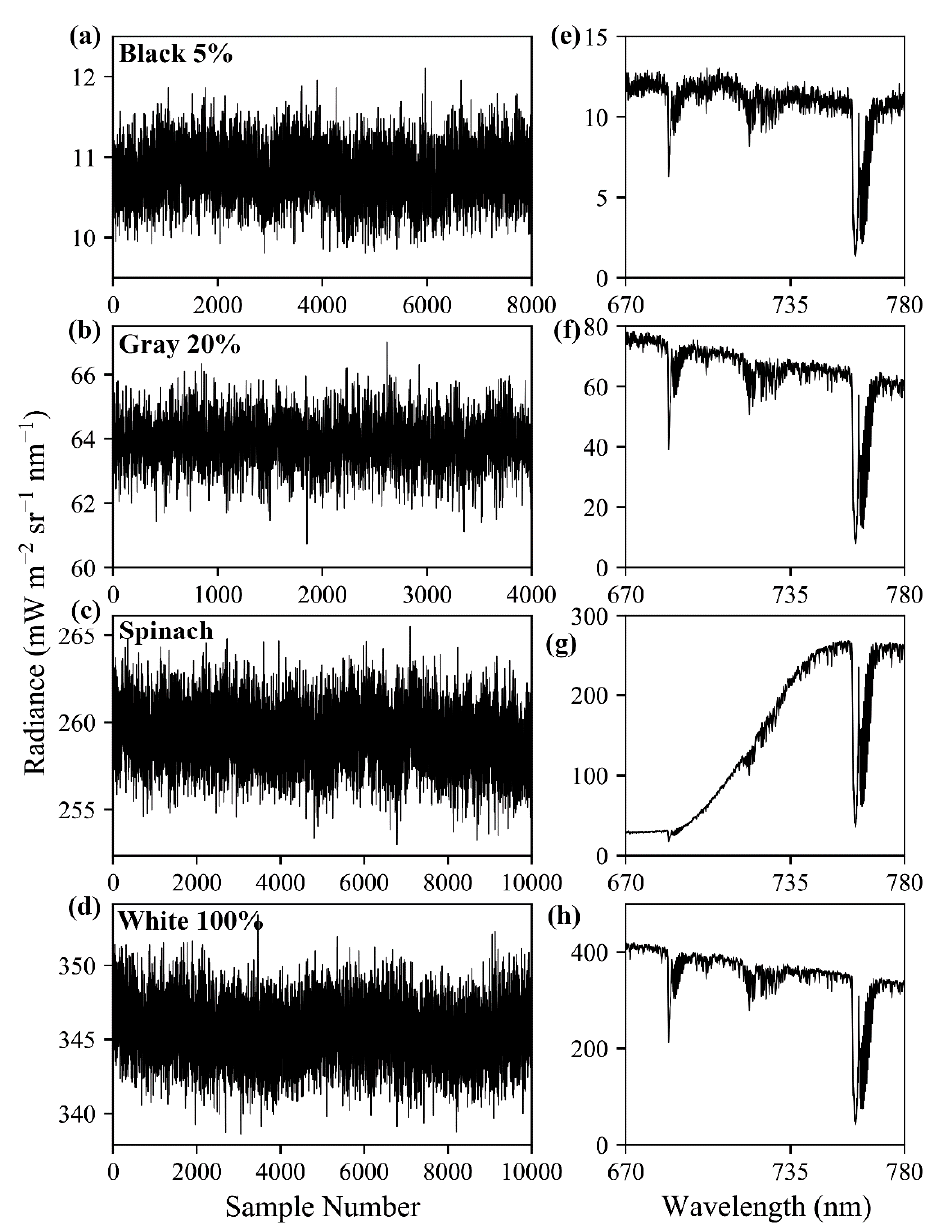
Figure 10. The radiance of FIREFLY spatial pixel 133, band 1272 (735.003 nm) over thousands of consecutive samples ( a – d ) of four targets, with an example of a single spectrum ( e – h ) from each panel, taken from spatial pixel 133.